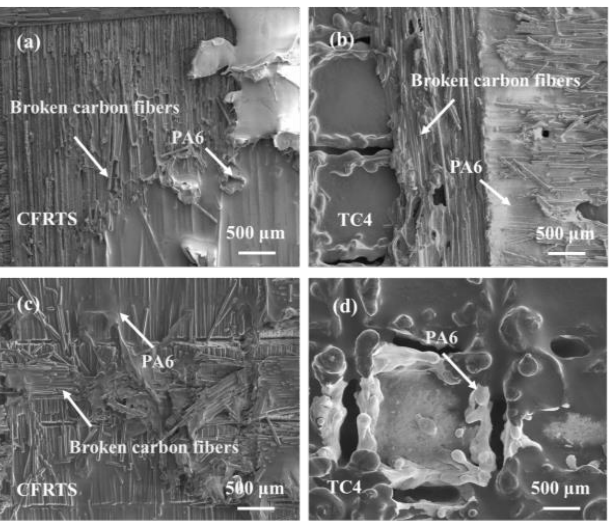
Figure 16. ( a , b ): Fracture surface morphology of sample 3; ( c , d ): fracture surface morphology of sample 4.